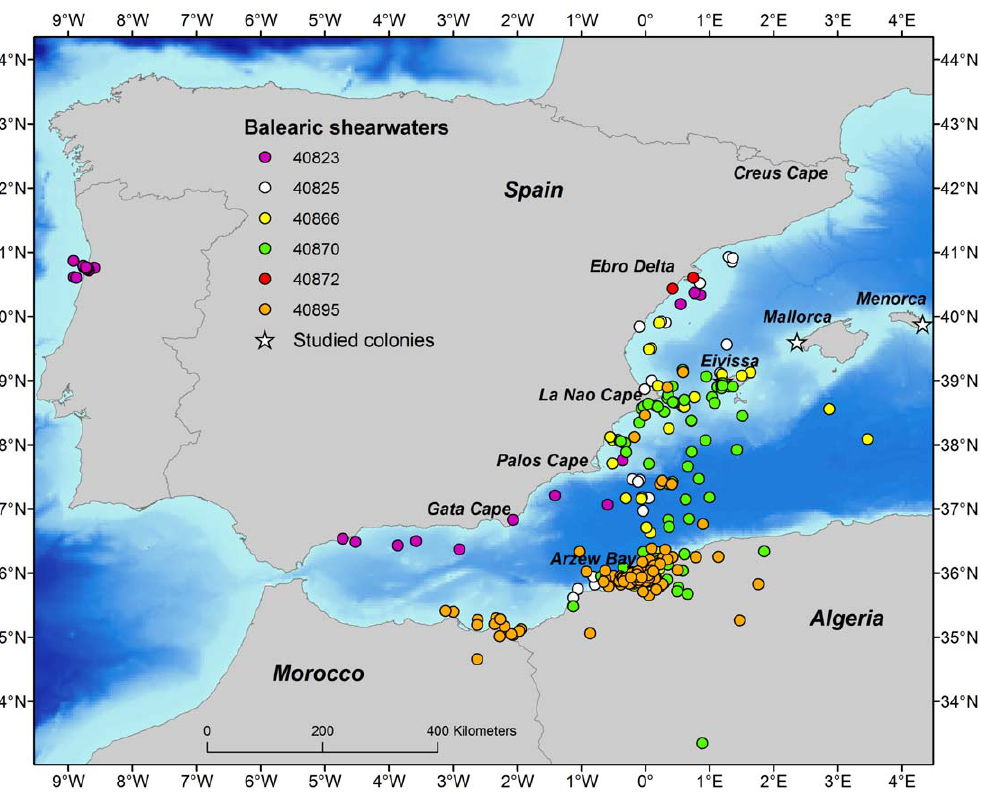
Figure 1. Satellite tracking of Balearic shearwaters during the chick-rearing period of 2011 from a southern breeding population (Conillera Island, western Mediterranean). Breeders stay in the western Mediterranean basin, whereas one non-breeder travels and stays in Portugal (violet points). Background values represent depth. Studied colonies are represented by white triangles.